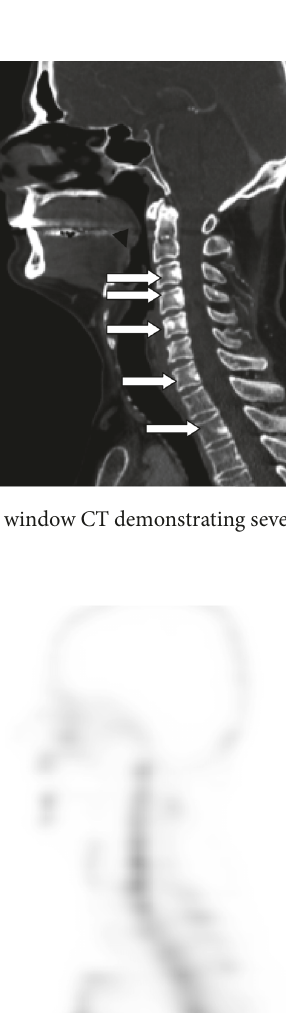
(b) (PET/CT) : Sagittal non-contrast enhanced CT does not demonstrate any osteoblastic lesions within the cervical or thoracic spine Figure